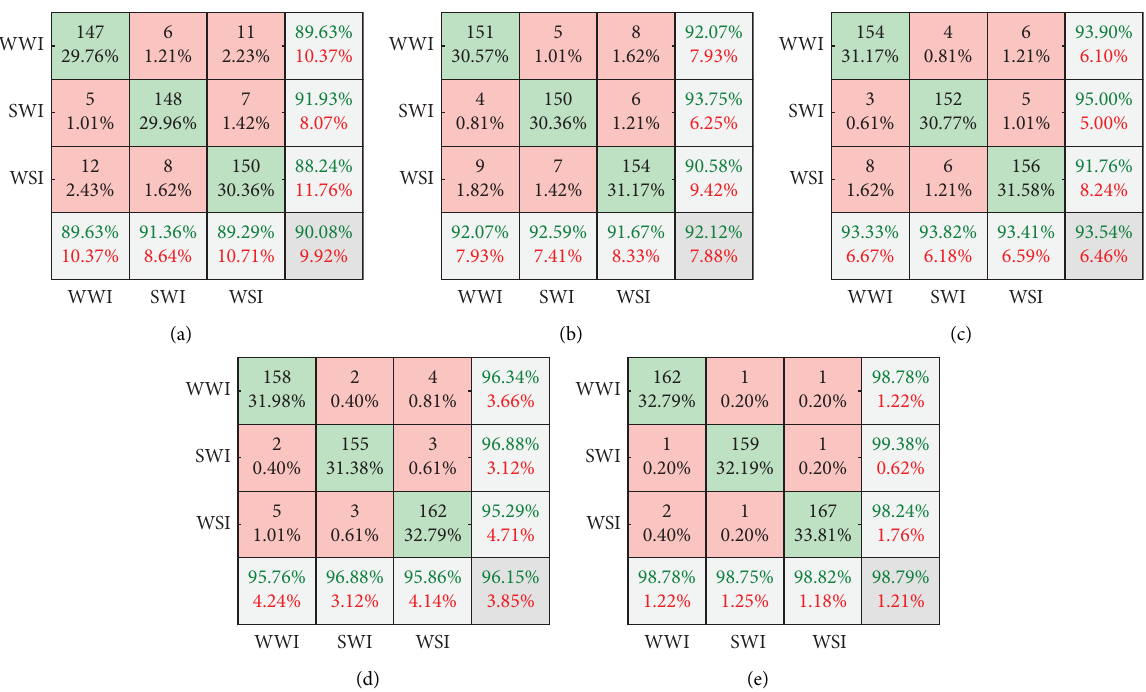
Figure 14: Confusion matrix at 0s before crossing the zebra crossing: the cyan color indicates the number of correct recognitions and their proportion in all samples, and the light red color indicates the number of misrecognitions and their proportion in all samples. Te rightmost column in the fgure is precision, and the bottom column is recall. (a) Confusion matrix of SVM; (b) confusion matrix of LSTM; (c) confusion matrix of AT-Bi-LSTM; (d) confusion matrix of stacking. Table 4: Model evaluation result at 0.5s before crossing the zebra crossing.